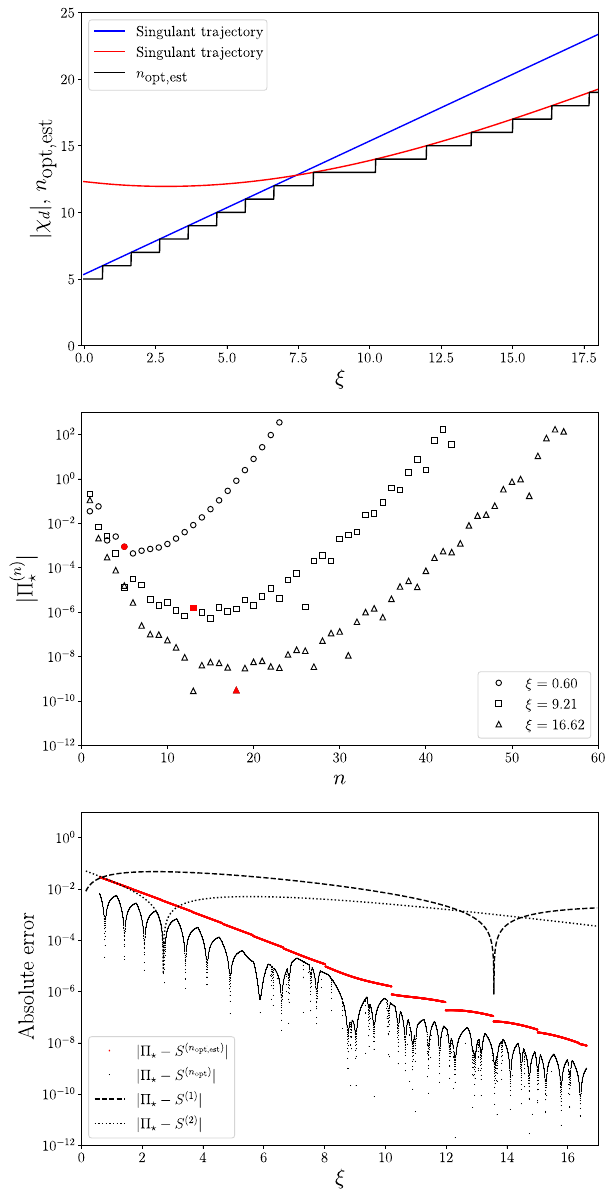
FIG. 8. Upper panel: evolution of the norm of the dominant j as a function of ξ along the flow line located at singulant j χ d x ¼ 0 for initial data [Eq. (109)]. A real singulant, whose trajectory is denoted by the solid blue line, dominates at early times. At late times, a complex-conjugated singulant pair, whose trajectory corresponds to the solid red line, takes over. The discontinuous solid black line corresponds to n , as given by opt ; est Eq. (104). Middle panel: coefficients of the gradient expansion at three selected times. The ones associated to the corresponding n have been highlighted in red. Lower panel: absolute error opt ; est of the optimal truncation (black crosses) and the truncation at order n (red dots). Crucially, the latter error provides an opt ; est upper bound for the former that displays the same time depend- ence. The dashed (dotted) black line represents the absolute error of the first-order (second-order)